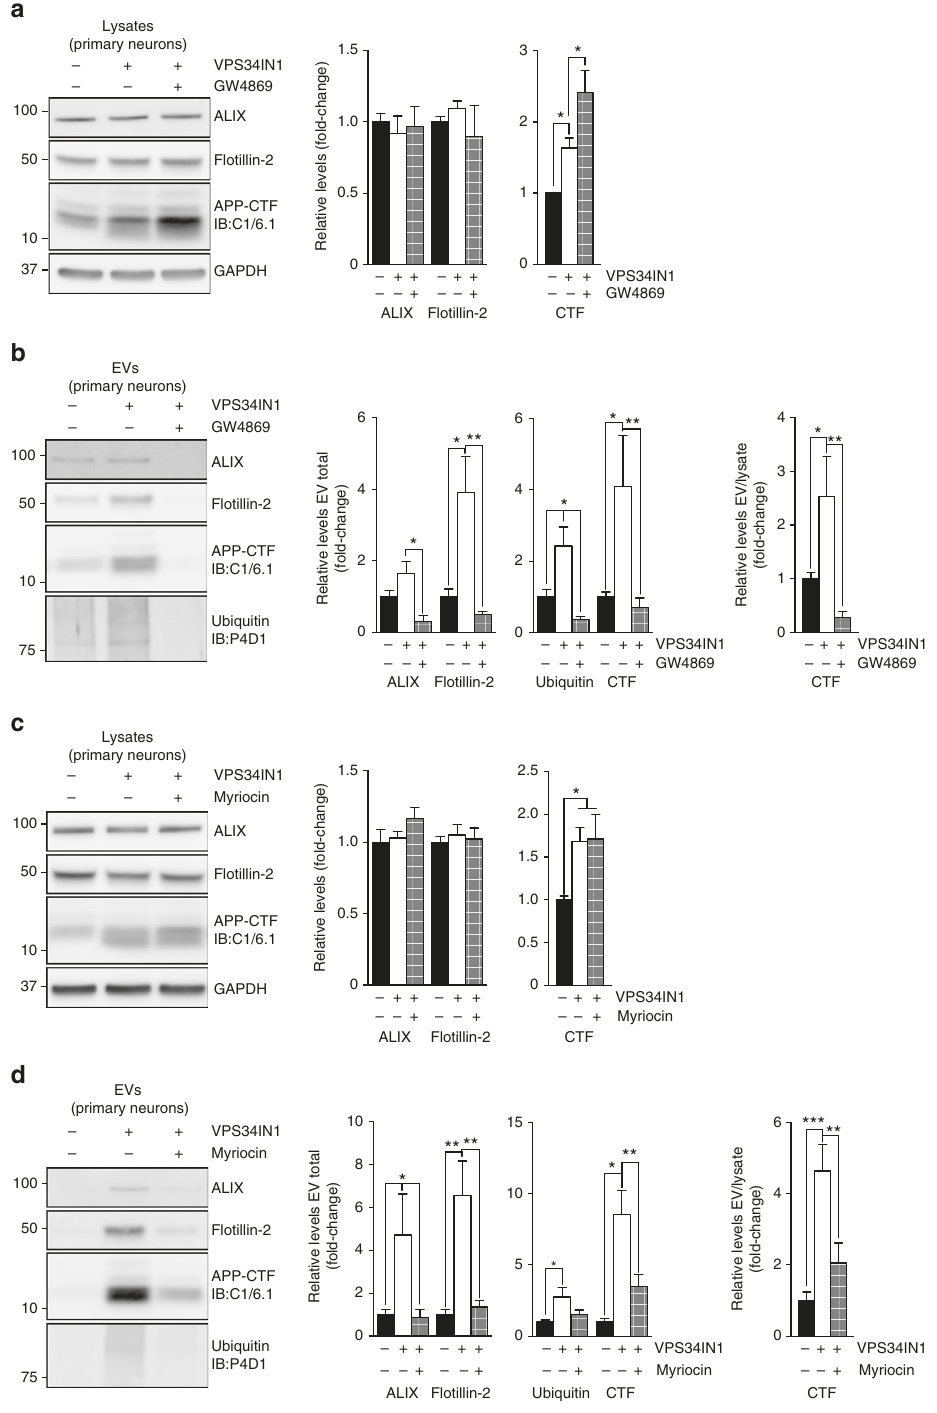
Fig. 6 Pharmacological blockade of neutral Sphingomyelinase 2 or inhibition of de novo sphingolipid synthesis inhibit VPS34IN1-induced release of exosomal APP-CTFs. a - d Western blot analysis of cell lysates and EVs from cortical neurons treated with vehicle, VPS34IN1 at 3 µ M or cotreated with GW4869 at 10 µ M or Myriocin at 1 µ M for 36 h. EV protein levels were normalized to lysate total protein (EV total) or lysate levels of the corresponding protein (EV/lysate ratio). Bar graph denotes average protein levels normalized to vehicle (mean ± SEM, N = 5 for vehicle, N = 6 for treated groups, from two independent experiments). * p < 0.05, ** p < 0.01, *** p < 0.001 in one-way ANOVA, Holm – Sidak ’ s multiple comparisons relative to controls. The most robust change, however, was a ∼ 2.5-fold increase in total BMP (Fig. 4c), re fl ecting increase in multiple molecular species of this phospholipid (Supplementary